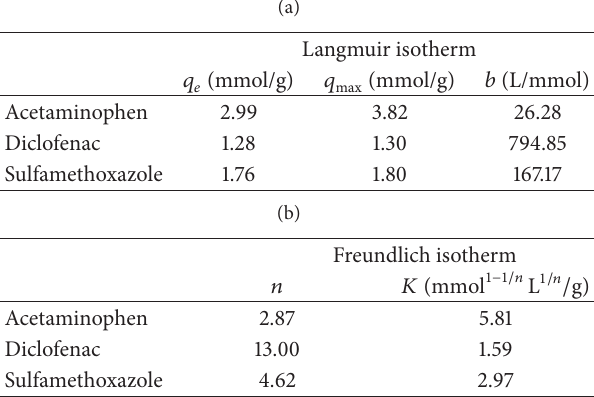
Table 3: Parameters of Langmuir and Freundlich isotherms in single-component system onto